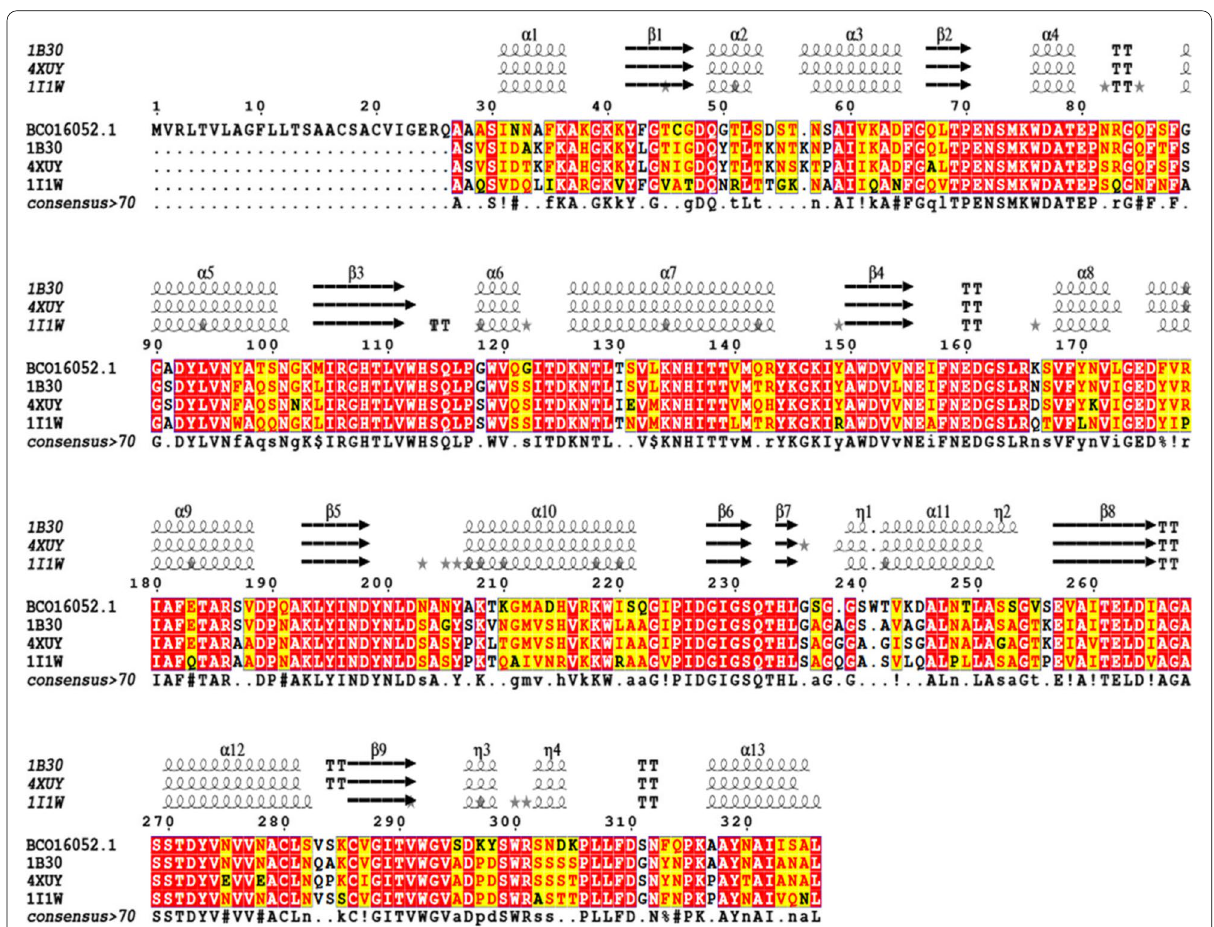
Fig. 21 Multiple structure alignment of deduced amino acids sequence of xynC gene with Aspergillus niger (PDB 4XUY _A) and Penicillium simplicissimum DSM 17393 (PDB ID